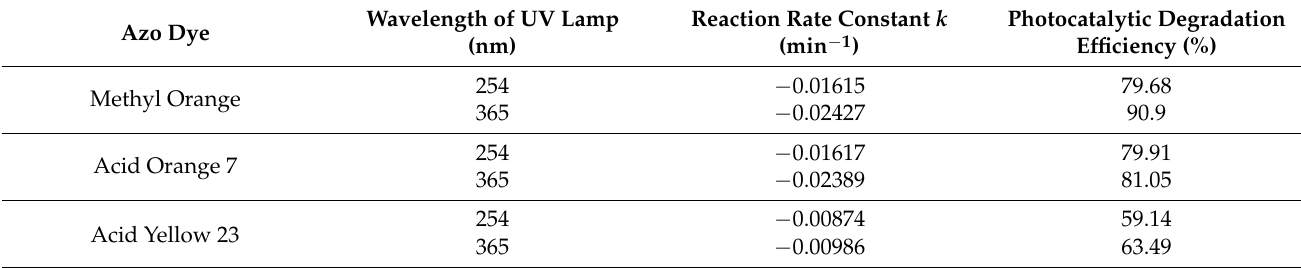
Experimental conditions: initial dye concentration 0.042 mM; wavelength of UV irradiation: 254 nm or 365 nm; H 2 O 2 concentration: 4.8 M; photocatalyst concentration: 1.0